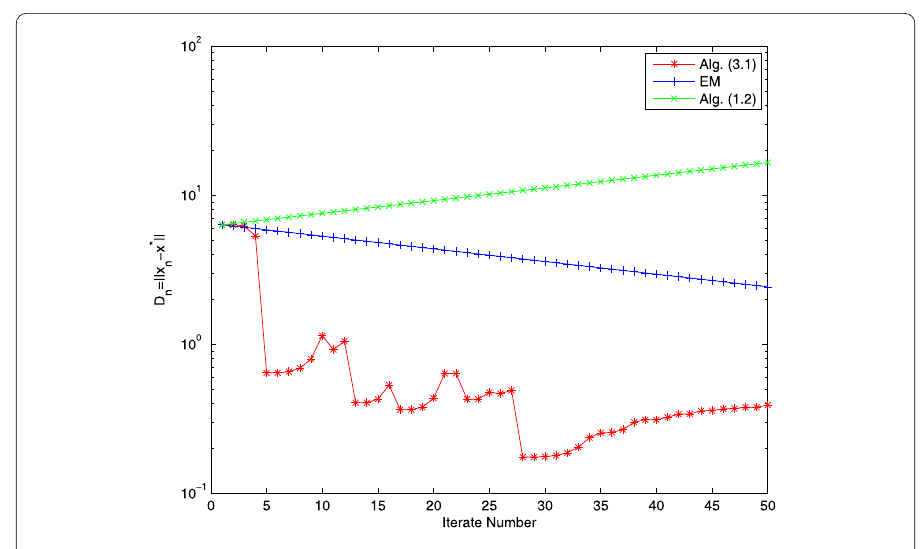
Figure 4 Numerical results as regards Example